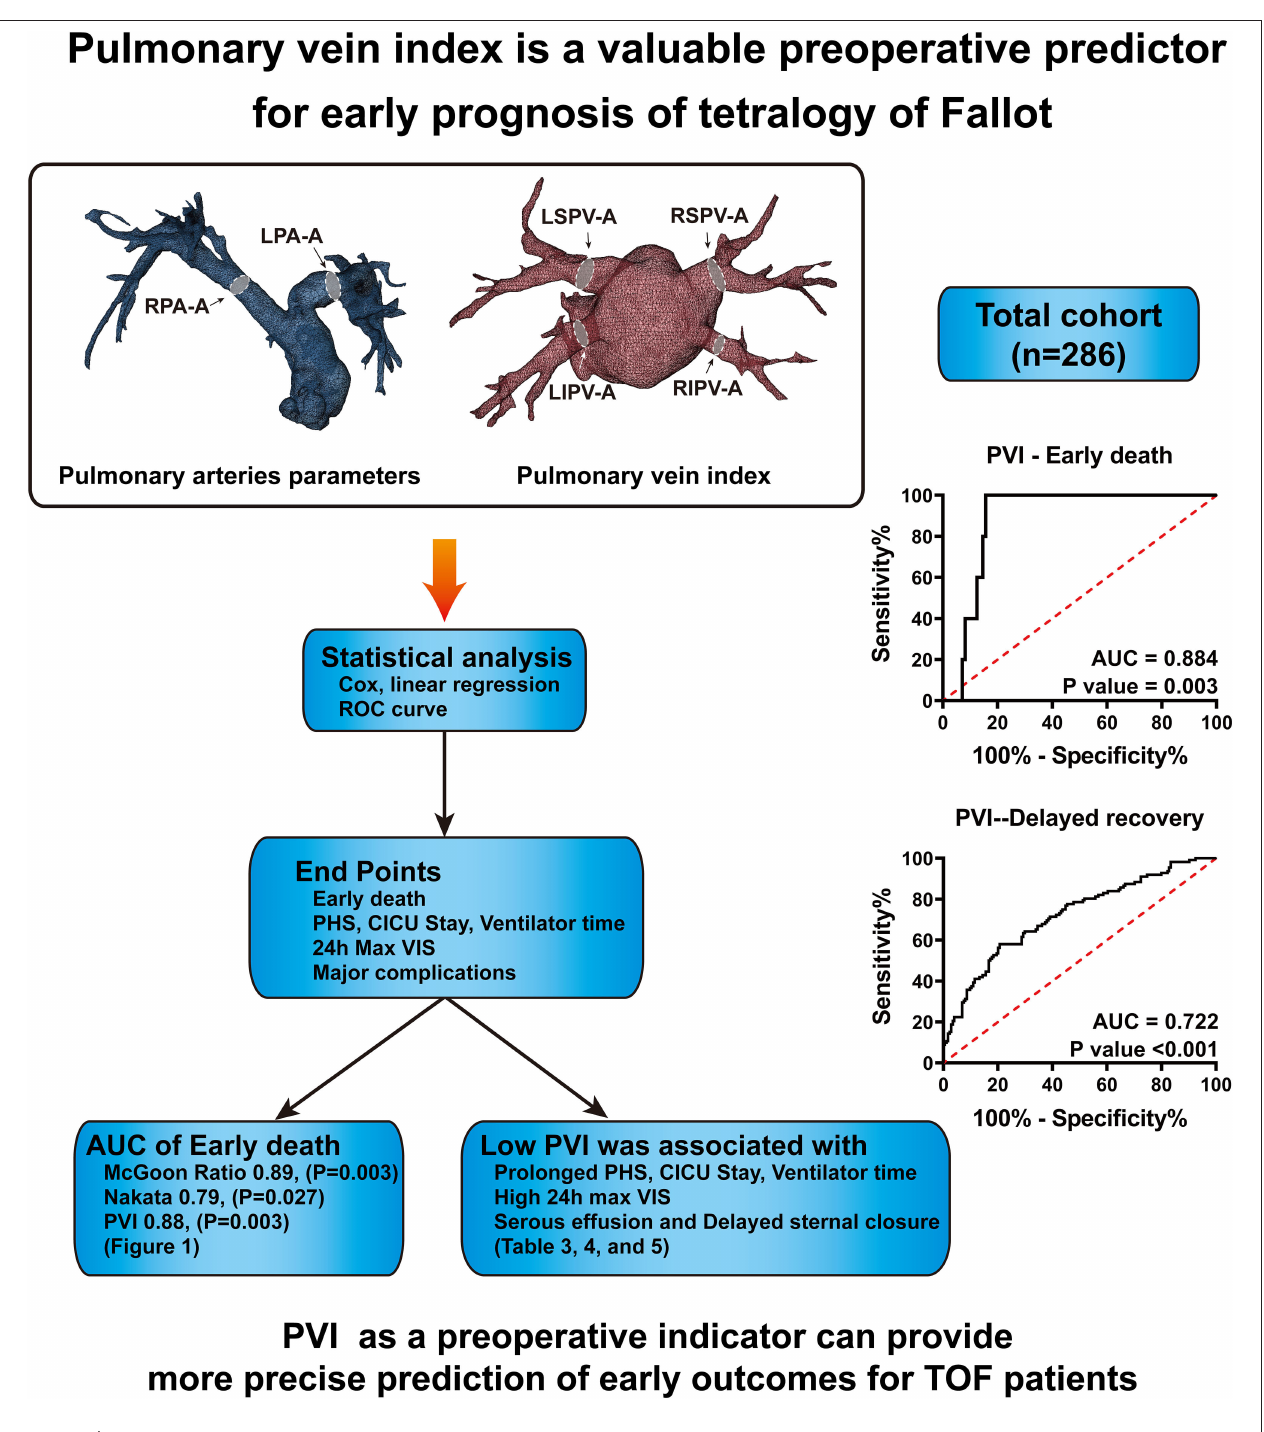
FIGURE 3 | In total, 286 patients’ CTA data were collected and analyzed. The sizes of pulmonary arteries and veins were measured, and the McGoon ratio, Nakata index and pulmonary vein index were calculated. ROC curve analysis demonstrates that PVI has a similar predictive value for early death as the McGoon ratio and Nakata index. PVI has better predictive value for delayed postoperative recovery.